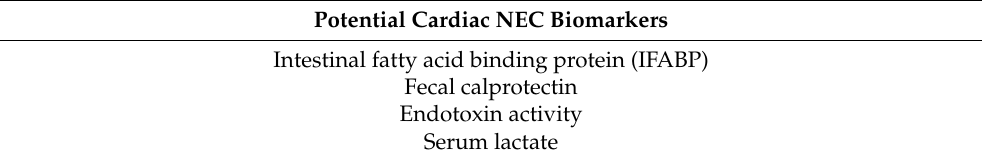
Table 2. Potential biomarkers for cardiac